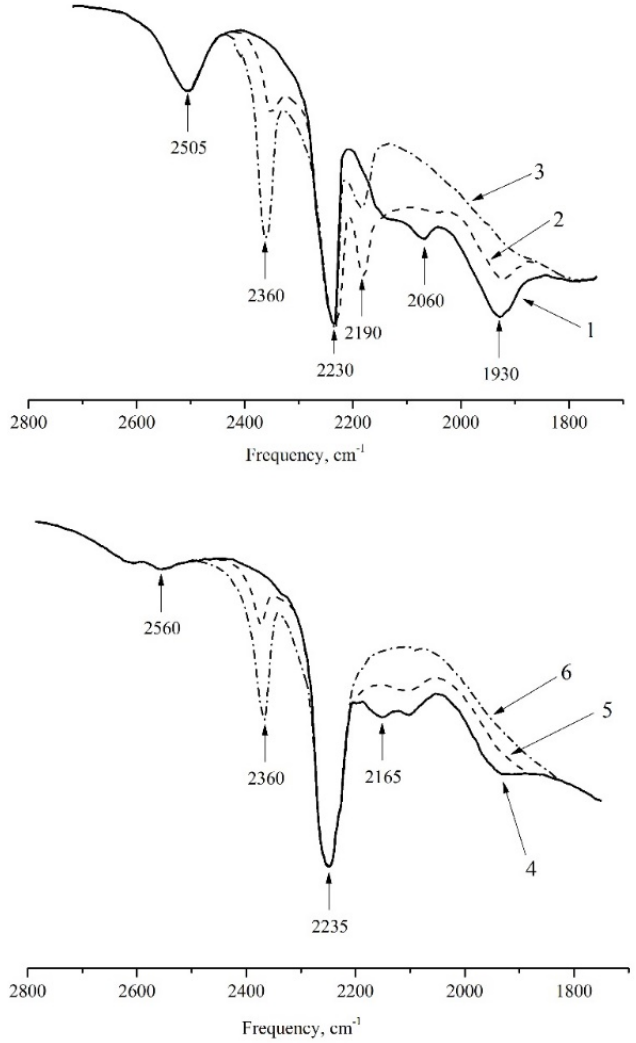
Figure 2. IR spectra of NO adsorbed at 20 °C and 10 Torr on Ca-FAU (Y) and Na-FAU (Y) (1, 4, respectively) followed by adsorption of CO at 20 °C and 10 Torr CO (2, 5, respectively), and heating at 150 °C for 1 h (3, 6, respectively).